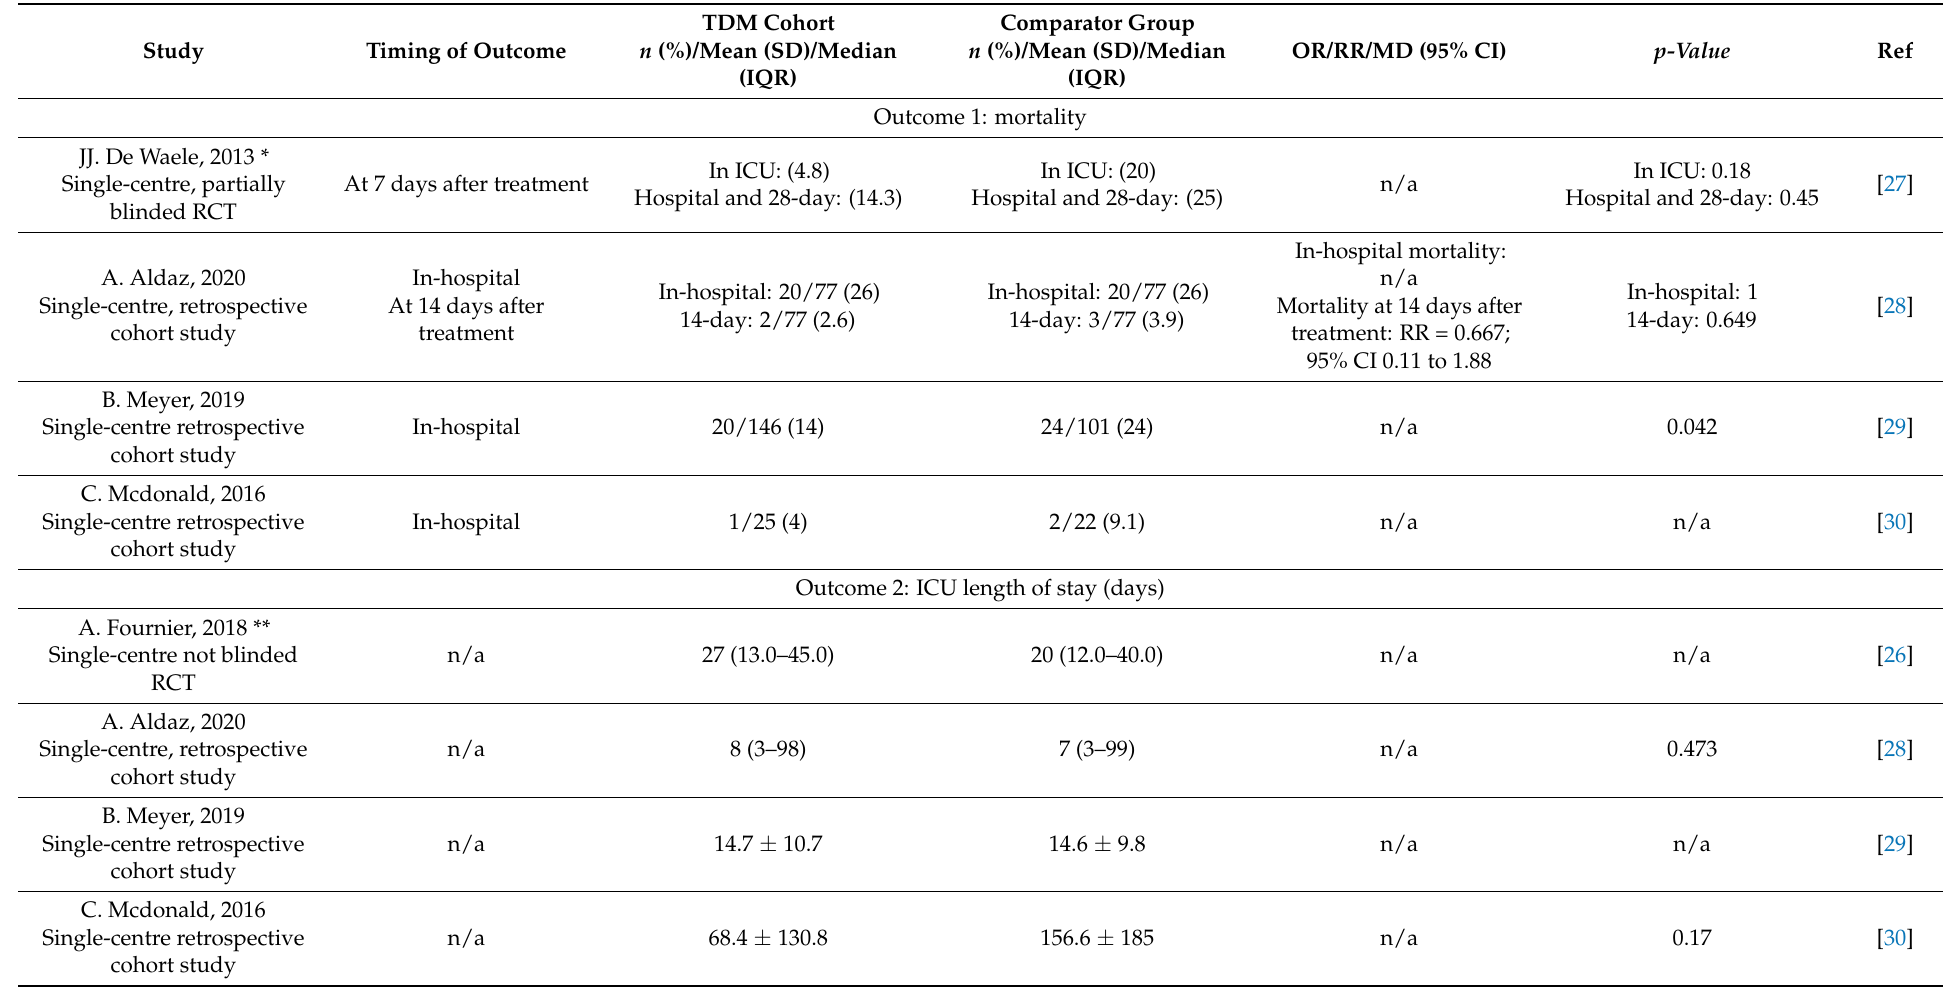
Table 2. Clinical